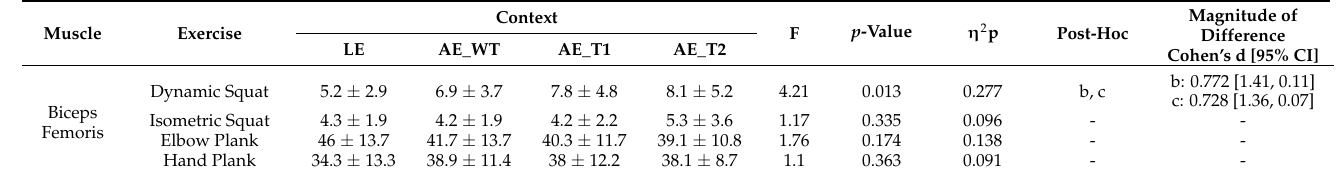
Table 4. Descriptive analysis (mean ± standard deviation) of EMG magnitude (%) and inferential analysis of the activation of the biceps femoris muscle as a function of the exercises and taking into account the context factor.